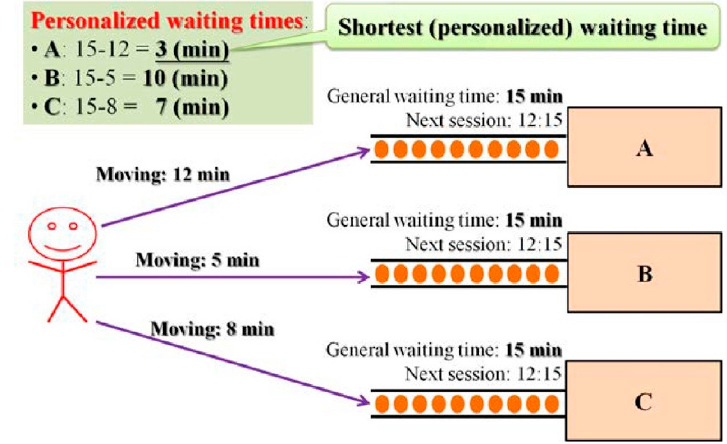
Figure 1. Basic concept of the proposed personalized waiting time.